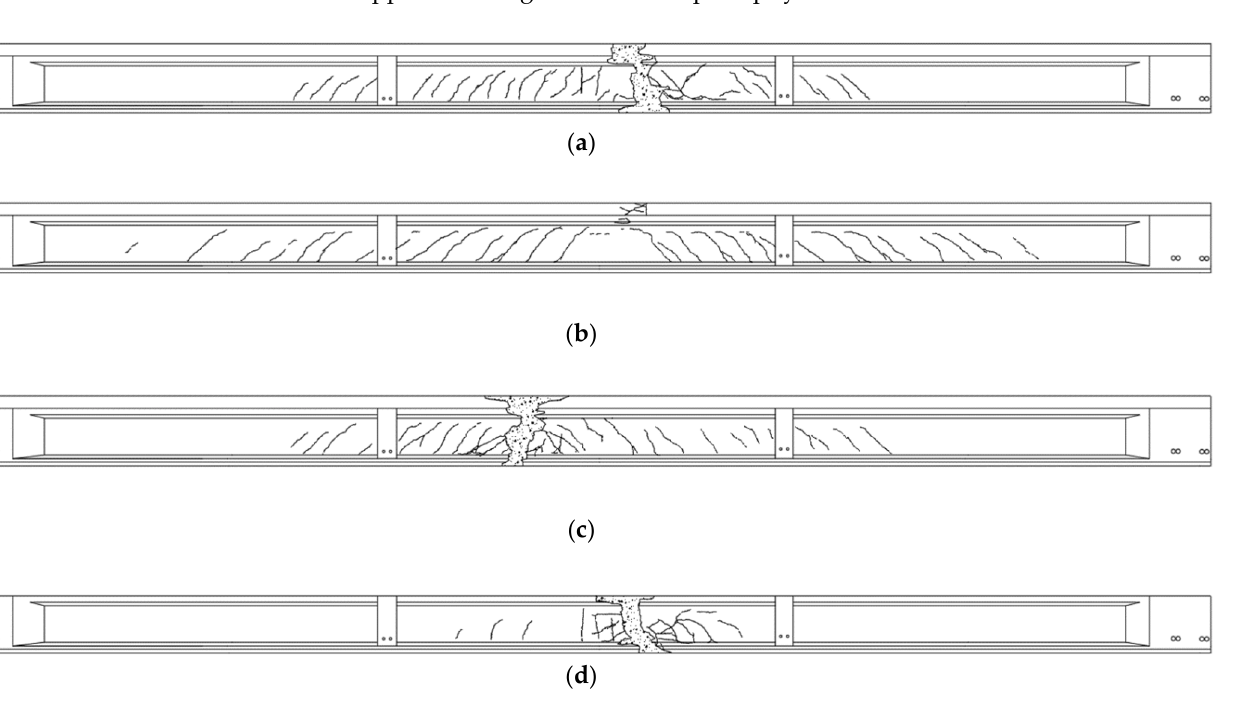
Figure 15. Crack pattern after the load tests of the ( a ) B3, ( b ) B8, ( c ) B4 and ( d ) B9-P47/46 girders.